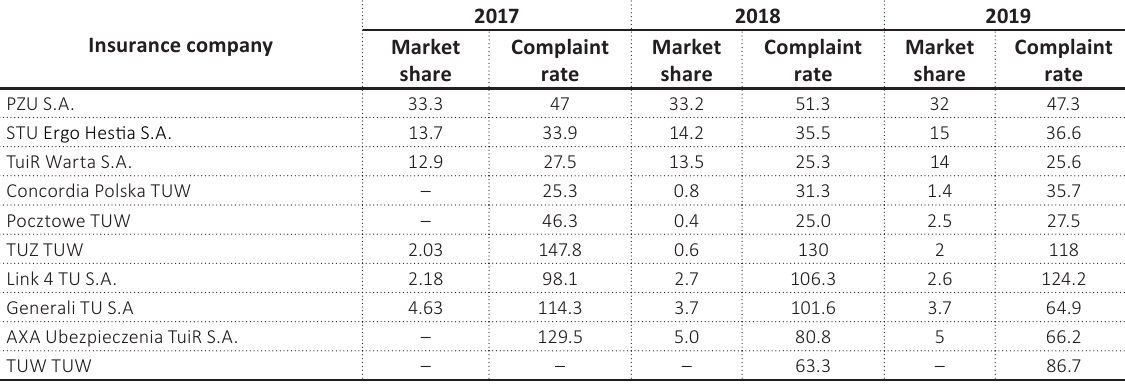
Table 2. Rating of Polish insurance companies in 2017–2019 *